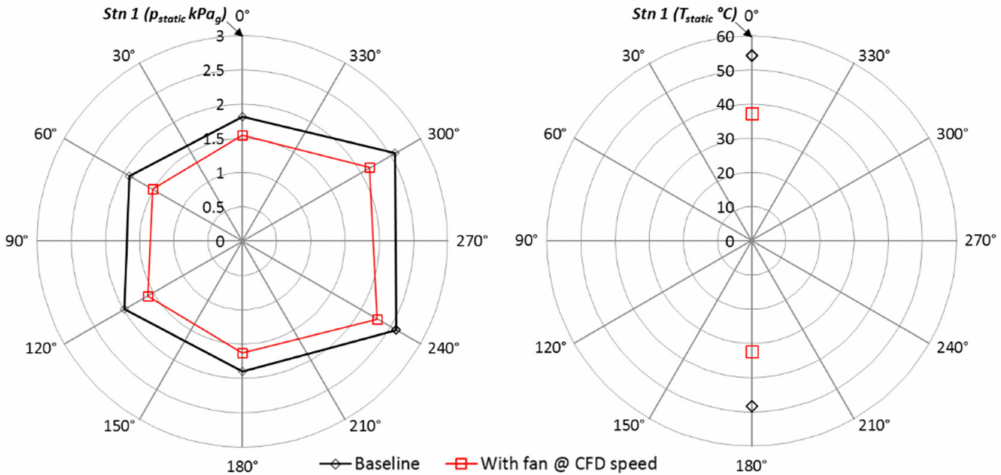
Figure 13. Impeller leading edge static pressure and temperature comparison at